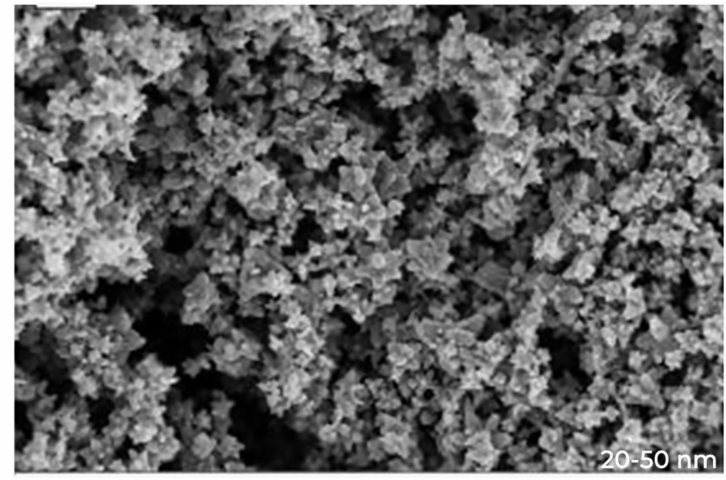
Figure 2. SEM image of ZnO nanoparticles.